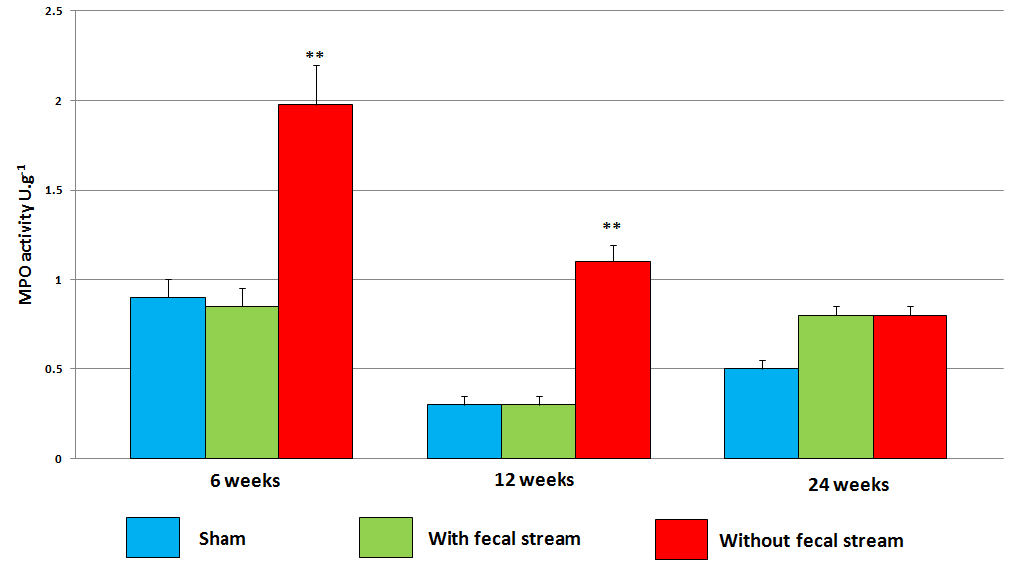
FIGURE 3 – MPO activity in sham and experimental subgroups (colon segments with and without fecal stream) for different durations of fecal stream diversion. ** = significant difference (without fecal stream × control and with fecal stream). Student t test.